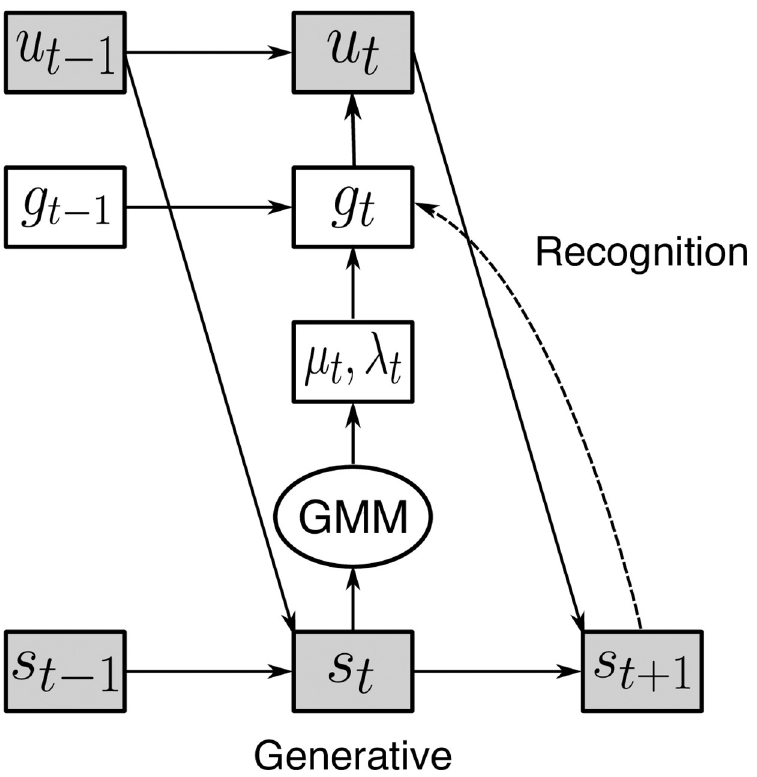
Fig 3. Model architecture. Observable trajectories y t are generated sequentially from control signals u t , which in turn derive from goals g . In the generative model, evolution of goals is determined by a Gaussian mixture model whose t parameters are given by the output of a neural network using state variables s the lagged history of y t and returns posterior samples of the